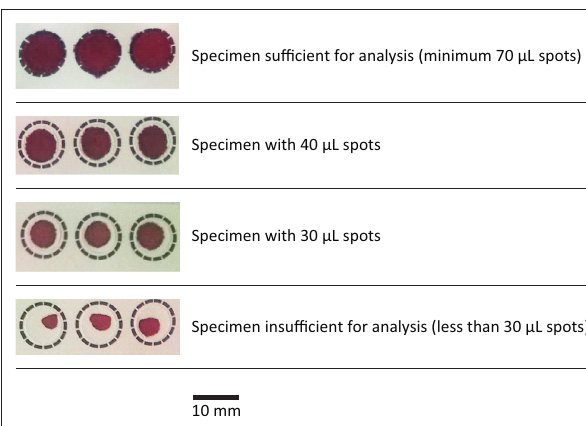
FIGURE 1: Example filter paper card with sufficient and insufficient blood